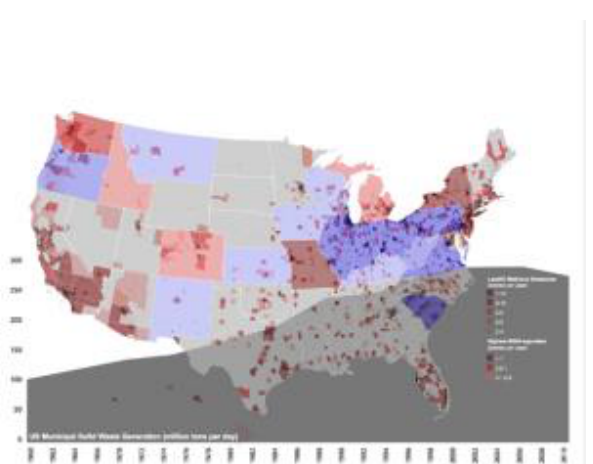
Figure 3. Mapping municipal solid waste generation, export, and emissions